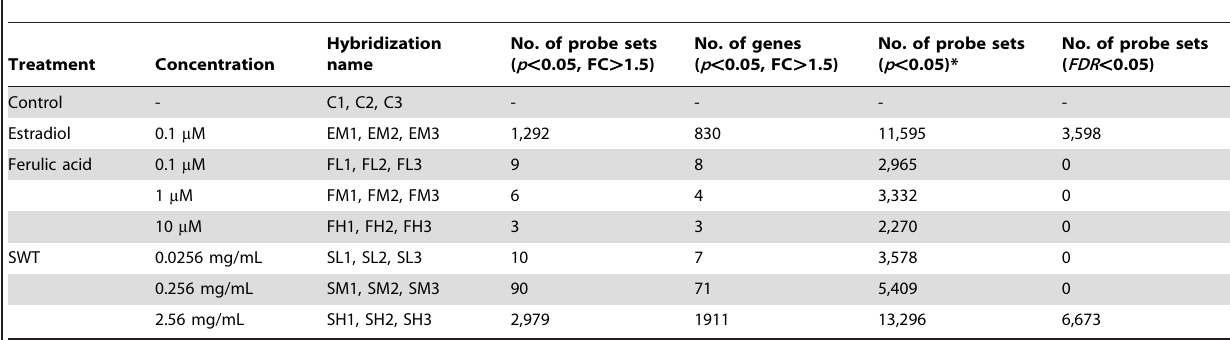
Table 1. Treatment information and the number of differentially expressed genes of each treatment group.